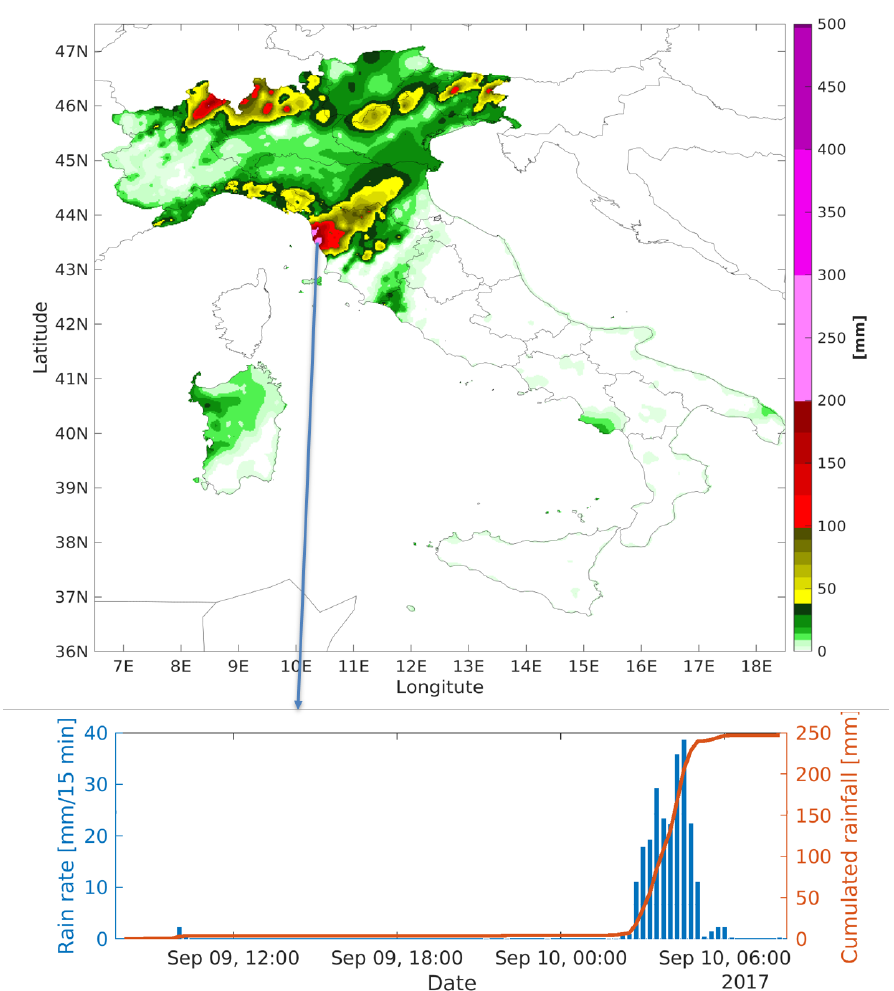
Figure 1. Quantitative Precipitation Estimate (QPE) using Italian raingauge data network for the time period 18UTC 9 September 2017–06UTC 10 September 2017 ( upper panel ) and raingauge observation near the Livorno area ( lower panel , courtesy of the Italian Civil Protection